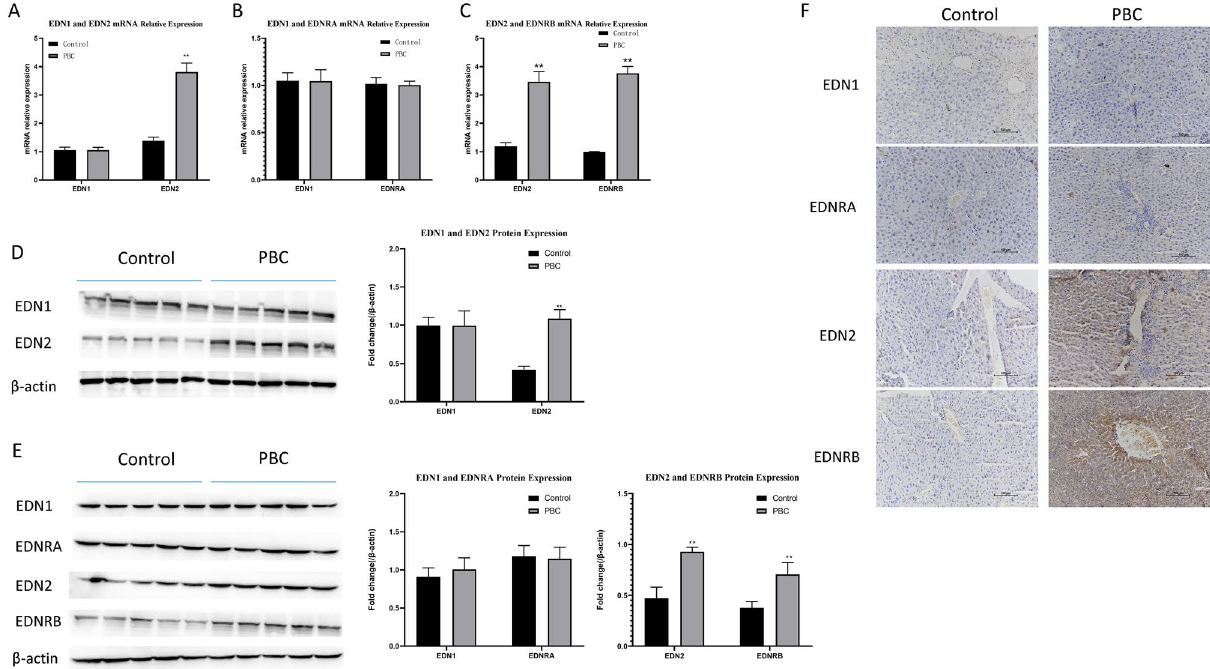
Figure 4. High expression of EDN2 and EDNRB in liver tissues and sera of PBC mice and wild type mice. ( A ) RT-qPCR technique was used to determine mRNA levels of EDN1 and EDN2 in sera of PBC mice (n = 10) and wild type mice (n = 10). ( B and C ) Measurement of EDN1, EDNRA, EDN2, and EDNRB mRNAs in liver tissues of BC mice (n = 10) and wild type mice (n = 10) was accomplished with RT-qPCR technique. ( D ) Levels of EDN1 and EDN2 proteins in serum samples of 5 random PBC mice and 5 random wild type mice were examined with western blotting technique. ( E ) Determination of EDN1, EDNRA, EDN2 and EDNRB proteins in liver tissues of 5 random PBC mice and 5 random wild type mice was accomplished with western blotting assay. ( F ) Illustrative IHC images of EDN1, EDNRA, EDN2, and EDNRB in liver tissues of PBC mice and wild type